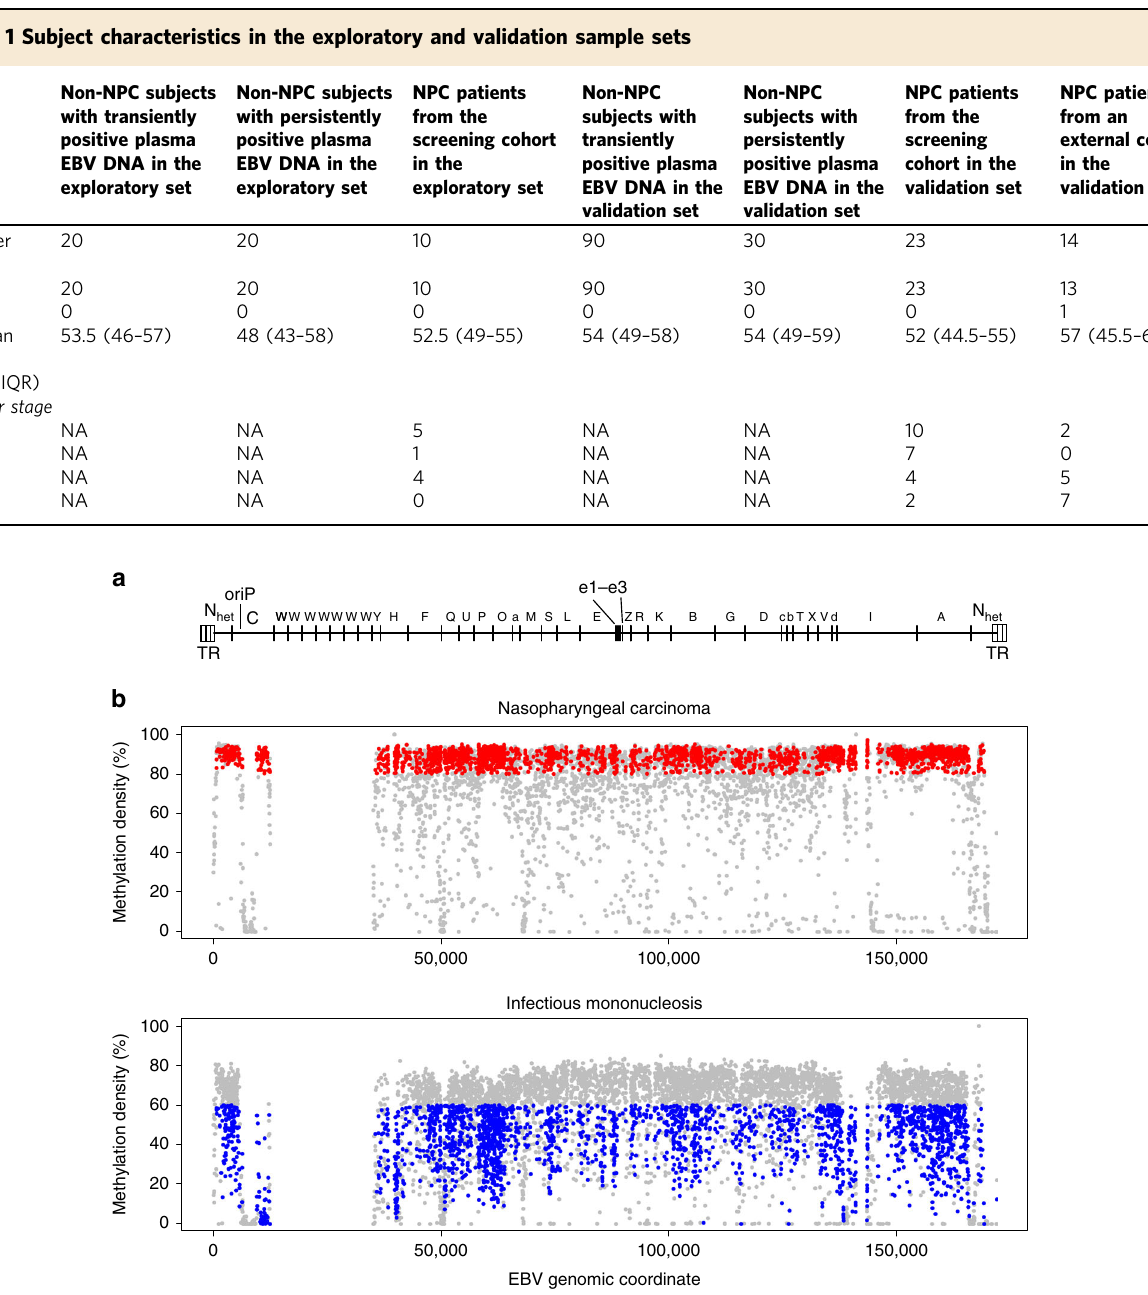
Fig. 2 Mining of NPC-associated DMRs in the EBV genome. a Bam HI restriction map of the EBV genome is shown. b Methylation densities of CpG loci across the EBV DNA genome from the pooled sequencing data of the 15 cases of NPC and the pooled data of the 5 cases of infectious mononucleosis used for mining of DMRs. Each dot (grey and coloured) shows the methylation density at a corresponding CpG site. A DMR was constructed by two or more differentially methylated CpG sites (>80% in the pooled data of NPC and <60% in the pooled data of infectious mononucleosis) within 200 bp. The coloured dots highlight those CpG sites which ful fi lled our criteria. The red dots are those CpG sites with the methylation densities greater than 80% in the pooled data of NPC and the blues dots are those with the methylation densities less than 60% in the pooled data of infectious mononucleosis. Viral DNA fragments mapped to the Bam HI-W repeat region presented ambiguities in alignment to the exact member of the repeat family. Hence, this region was